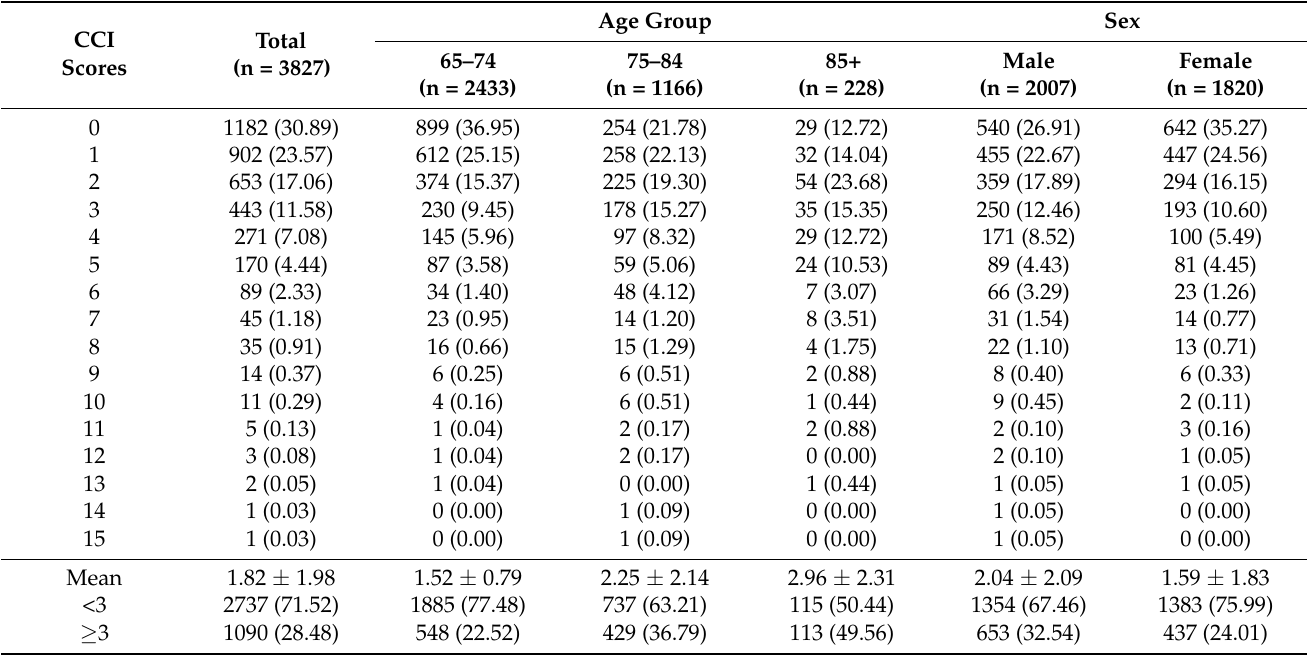
Table 2. CCI scores and numbers of patients (%). Comparison of age group and sex.